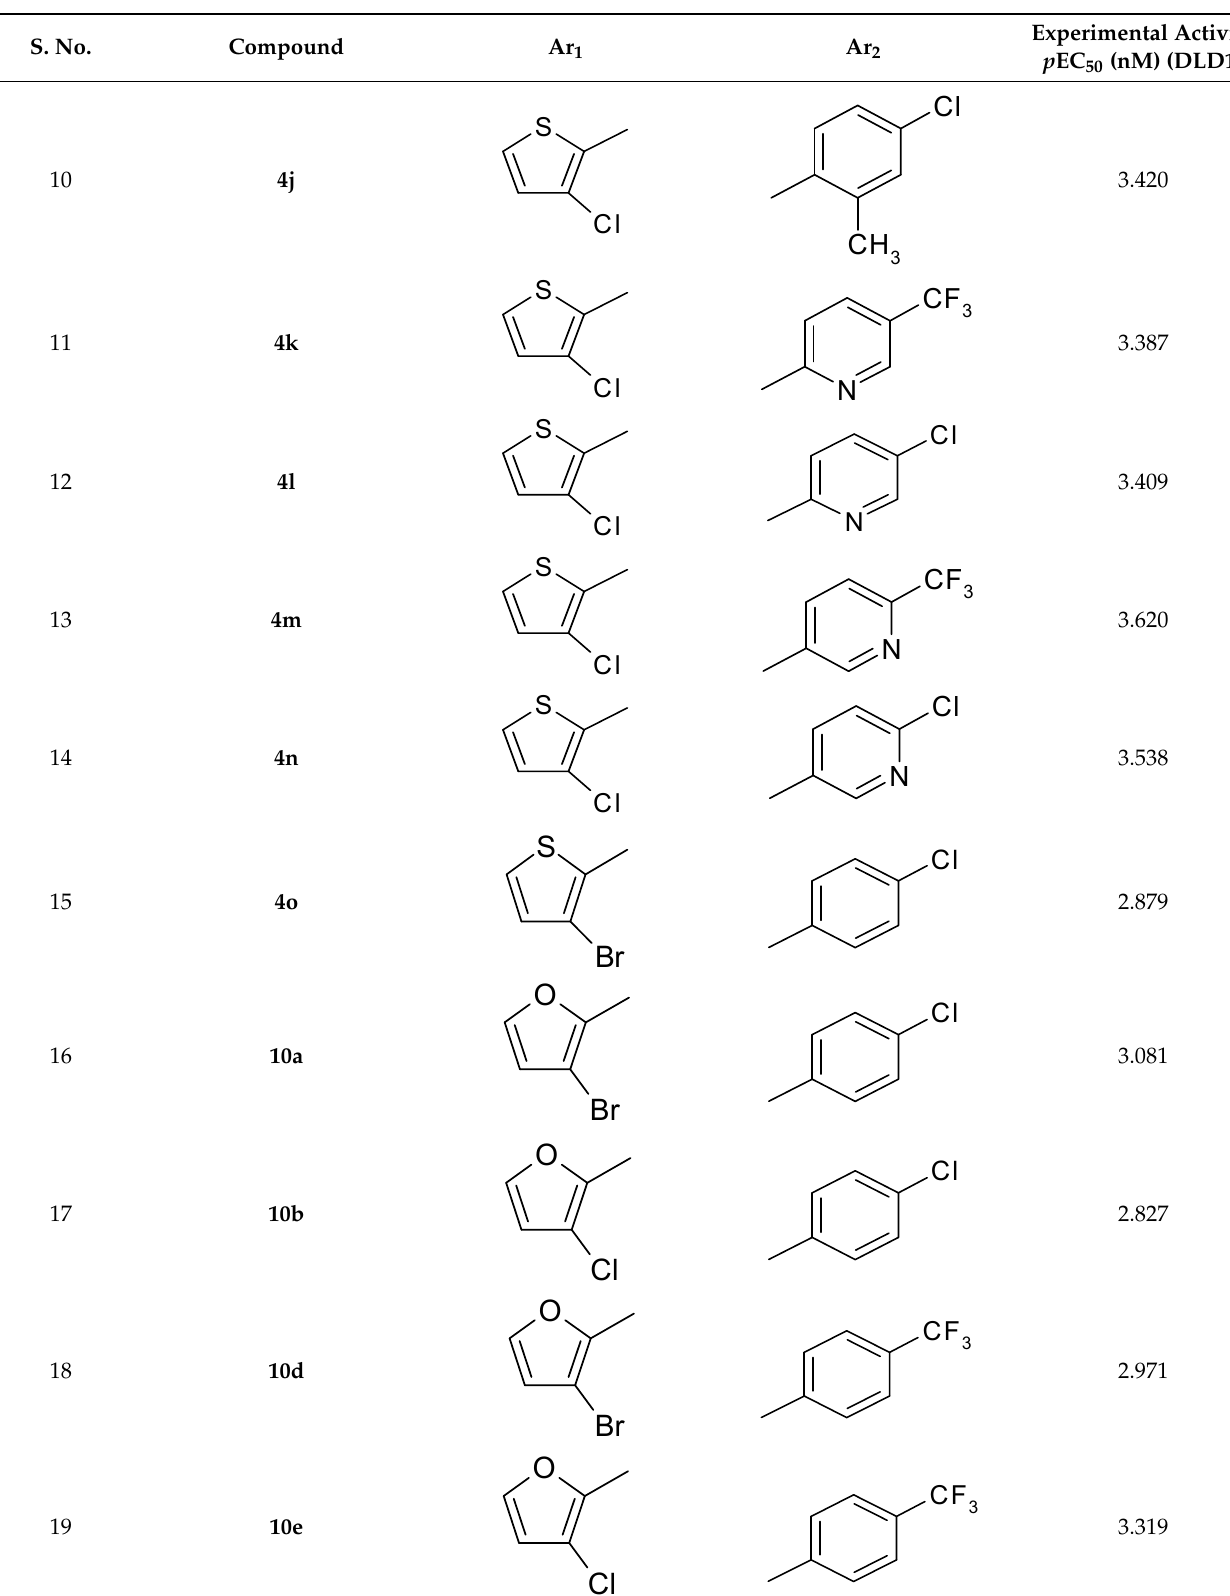
Table 1. Cont. Table 1. 1,2,4-Oxadiazole analogues and their experimental caspase-3 activator activity.